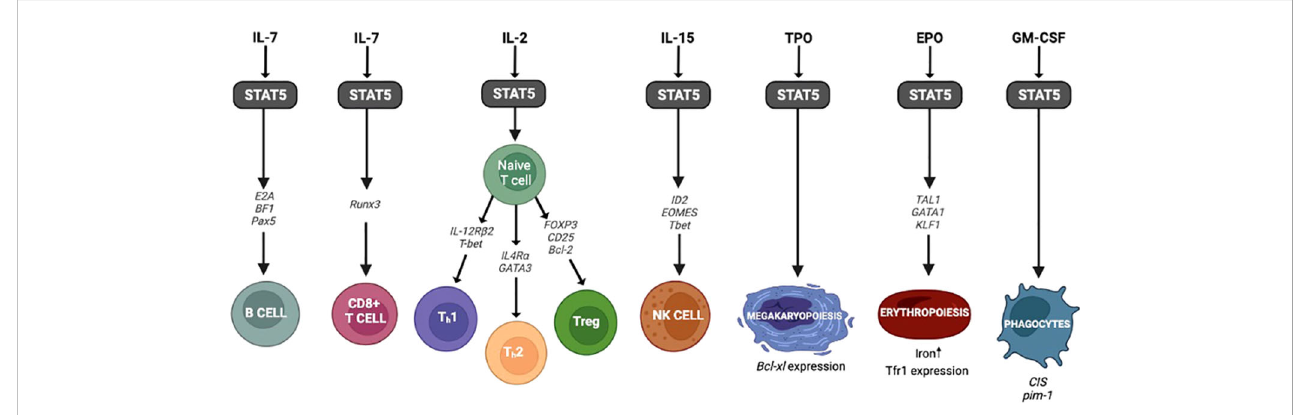
FIGURE 3 STAT5 and hematopoiesis. The genes and transcription factors involved in hematopoiesis following activation of